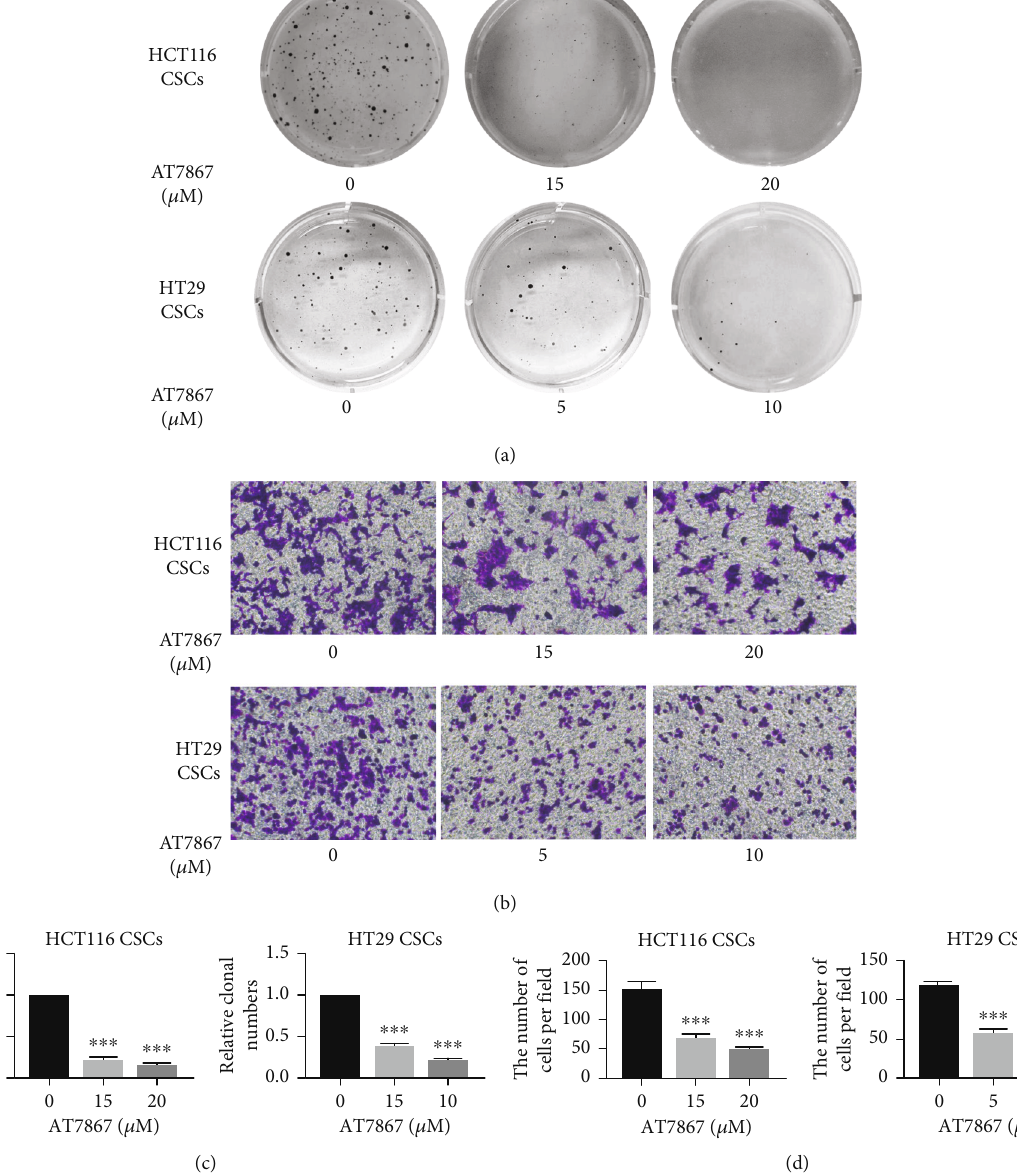
Figure 3: AT7867 inhibits the invasion ability of CSCs. (a – d) CSCs were treated with AT7867 for 24 h. Representative images of colony formation and Transwell. ∗ P < 0 : 05 , ∗∗ P < 0 : 01 , and ∗∗∗ P < 0 : 001 vs. the